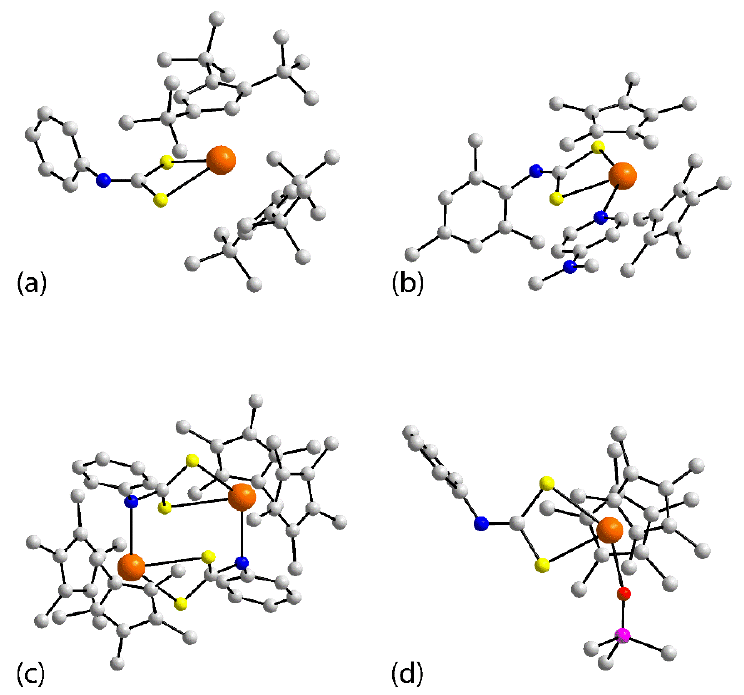
Figure 8. Molecular structures of ( a ) (1,2,4-tBu 3 C 5 H 2 ) 2 Th[S 2 C=N(Ph)] ( 33 ), ( b ) (Cp*) 2 Th(NC 5 H 4 NMe 2 - 8. 4)[S 2 C=N(mesityl)] ( 34 ), ( c ) {(Cp*) 2 Th[S 2 C=N(Ph)]} 2 in 35 , and ( d ) (Cp*) 2 U(O = PMe 3 )[S 2 C=N(Ph)] ( b ) (Cp*) 2 Th(NC 5 H 4 NMe 2 -4)[S 2 C=N(mesityl)] ( 34 ), ( c ) {(Cp*) 2 Th[S 2 C=N(Ph)]} 2 in 35 , and ( 38 ). ( d ) (Cp*) 2 U(O = PMe 3 )[S 2 C=N(Ph)] ( 38